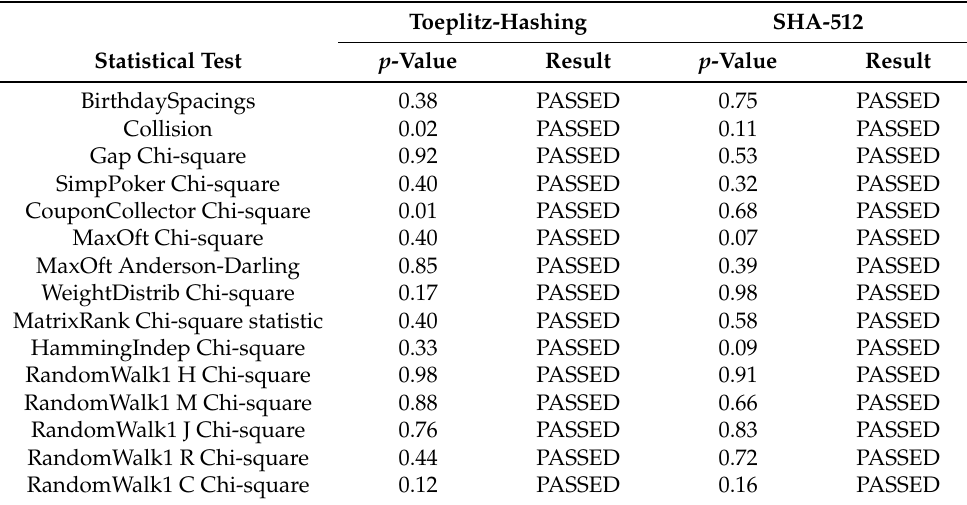
Table A1. TestU01’s SmallCrush results. For tests with multiple variants the worst case is reported.